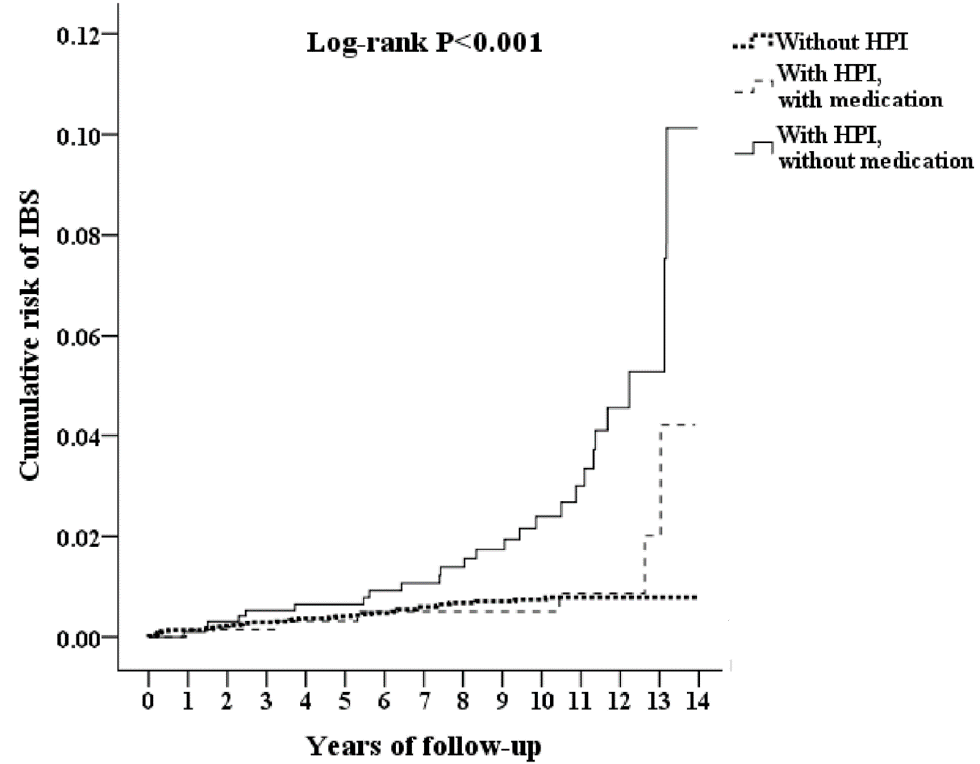
Figure2. Kaplan–MeierforcumulativeriskofIBSinpatientsaged14andoverstratifiedby Helicobacterpylori Figure 2. Kaplan–Meier for cumulative risk of IBS in patients aged 14 and over stratified by infection (HPI) with the log-rank test. Without HPI vs. With HPI, without medication: Log-rank P < 0.001. Helicobacter pylori infection (HPI) with the log-rank test. Without HPI vs. With HPI, without Without HPI vs. With HPI, with medication: Log-rank P = 0.479. With HPI, without medication vs. medication: Log-rank P < 0.001. Without HPI vs. With HPI, with medication: Log-rank P = 0.479. With With HPI, with medication: Log-rank P < HPI, without medication vs. With HPI, with medication: Log-rank P < 0.001. In the subgroup analysis comparing patients with and without H. pylori infection (Table 3), the overall incidence of IBS was 109.5 per 100,000 person-years in the study cohort and 33.83 per 100,000 person-years in the control cohort. Female and male H. pylori -infected patients showed an increased risk of developing IBS (total aHR = 3.108, p < 0.001; 3.074 in the corresponding age group of females, p < 0.001; 3.228 in the corresponding age group of males, p = 0.003). In the age group analysis, patients with H. pylori infection in the 44 to 64-year age group were independently associated with an increased risk following IBS diagnosis compared with patients without H. pylori infection (aHR= 4.971, p < 0.001). In the insured premium group analysis, H. pylori -infected patients in the <18,000 group showed an increased risk of developing IBS (aHR = 3.108, p < 0.001). In the pre-existing condition group analysis, H. pylori -infected patients with CAD, CVA, HTN or DM displayed an increased risk of developing IBS (aHR = 3.268, p < 0.001 in CAD; aHR = 3.605, p < 0.001 in CVA; aHR=